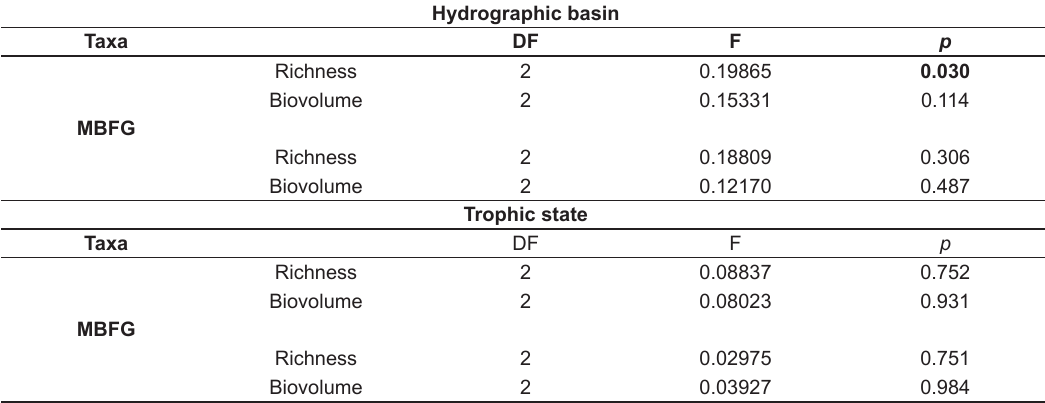
Table 3. PERMANOVA results applied to richness and biovolume of taxa and MBFG data to evaluate